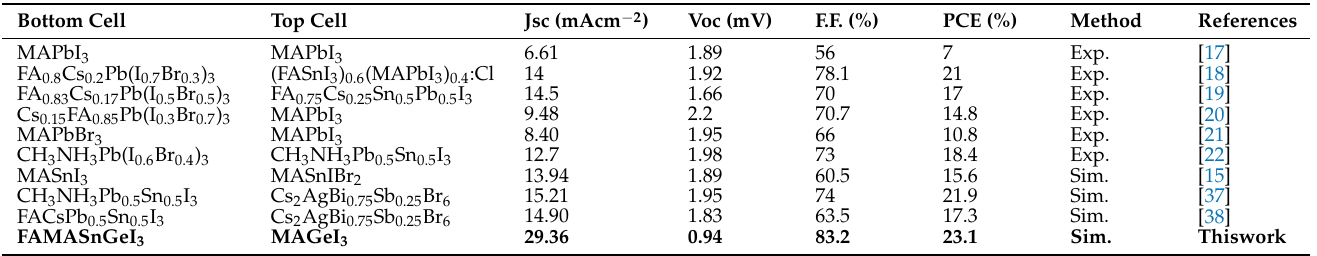
Table 1. Comparison of tandem solar cells with previous experimental and simulated reports